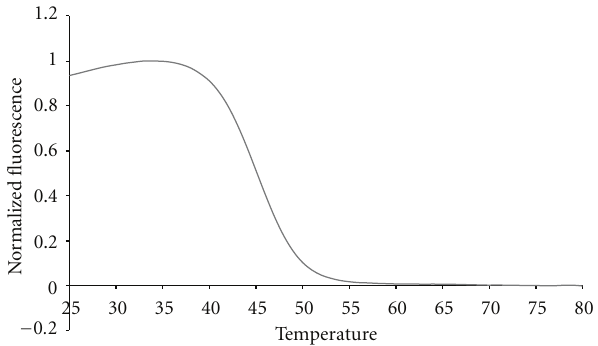
Figure 5: The normalized anneal curve showing the coagulase negative 16S targets in the Quasar channel with their highest peak normalized to 1.0.